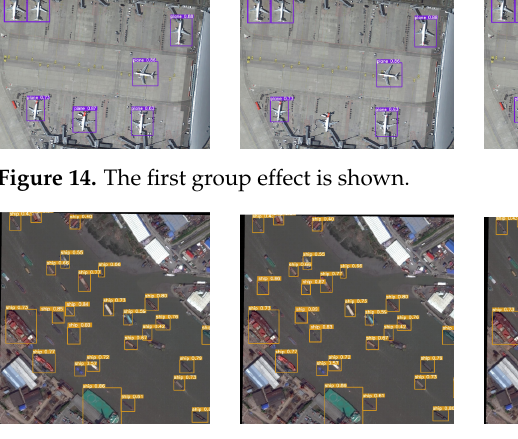
Figure 15. The second group effect is shown.